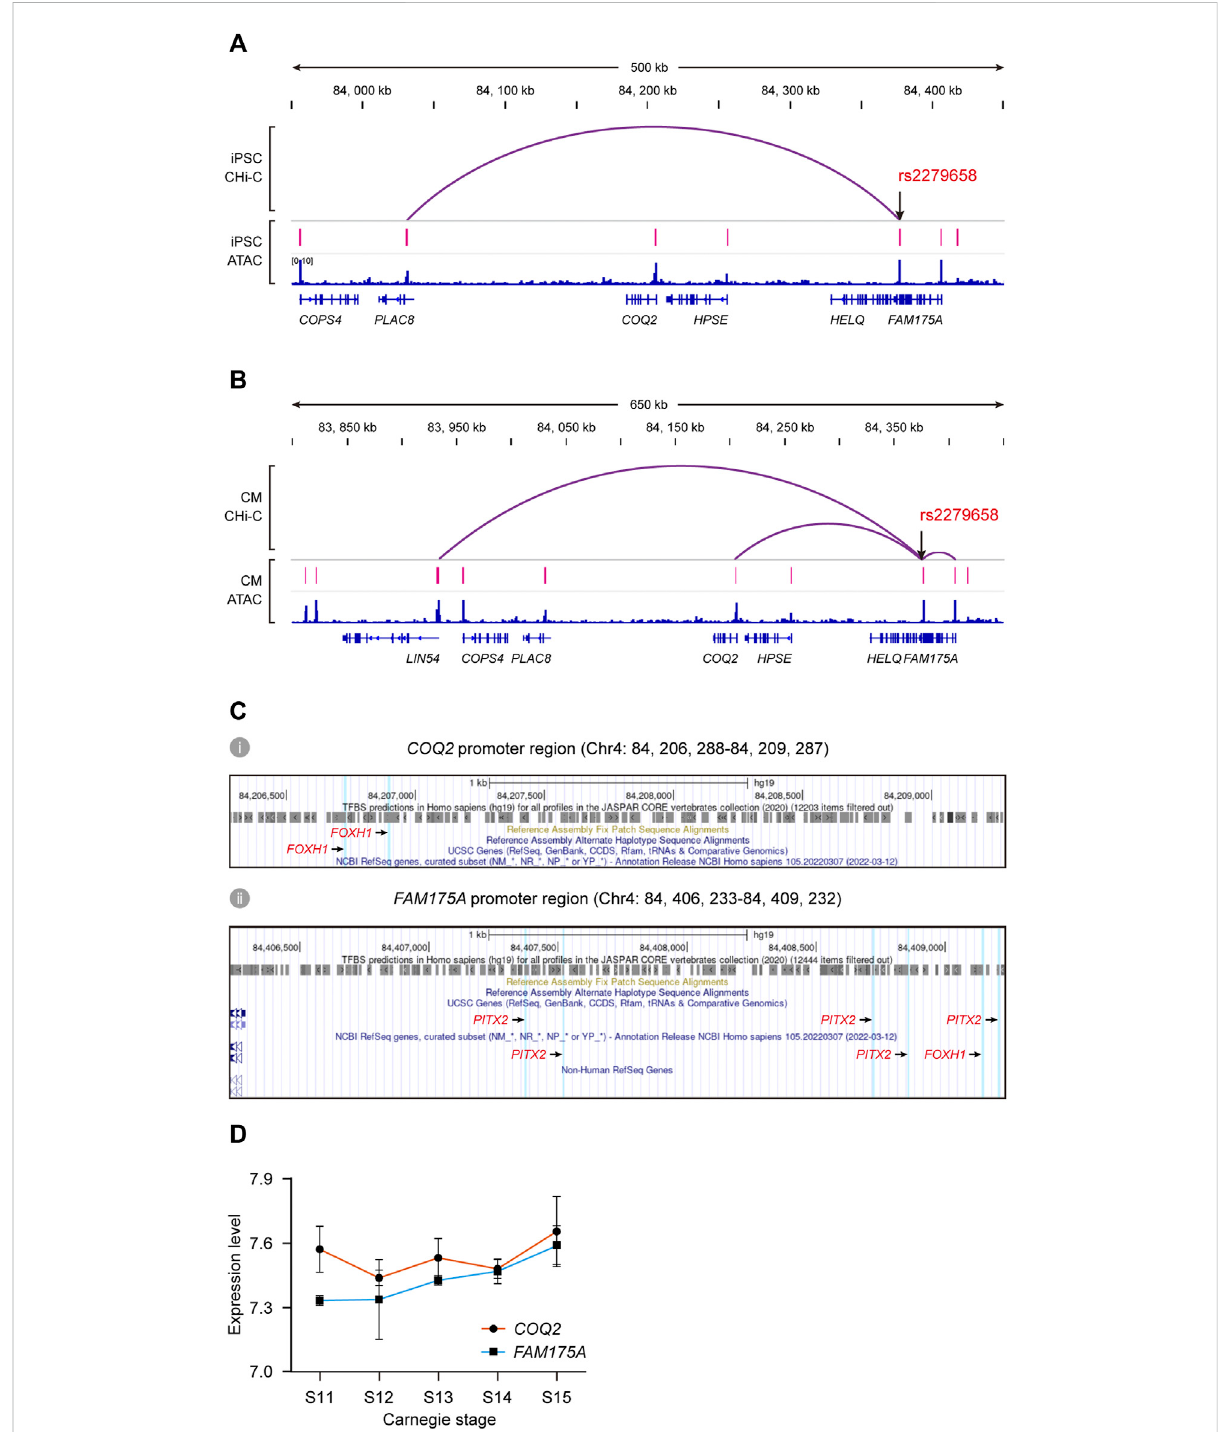
FIGURE 5 Identi fi cation of potential target genes of cis -regulatory SNP rs2279658. (A,B) IGV views of signi fi cant promoter CHi-C loops at the rs2279658 locus in iPSC (A) and CM (B) . (C) Predicted TF binding sites in promoter regions of COQ2 (i) and FAM175A (ii), respectively. FOXH1- and PITX2- binding sites are highlighted in blue. (D) Line plot showing expression levels of COQ2 and FAM175A across human cardiac morphogenesis.